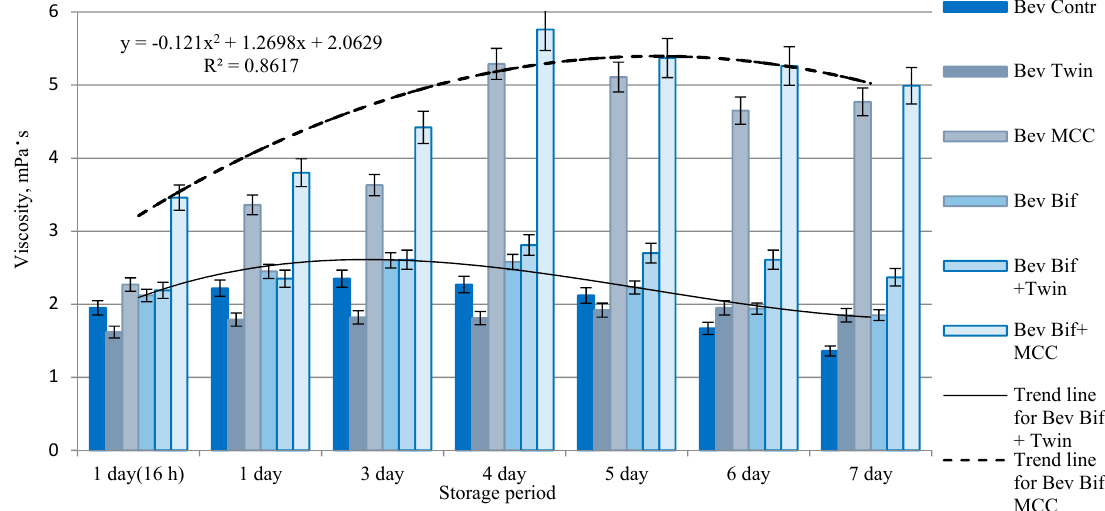
Figure 3. Dynamic viscosity of plant beverages stabilized with ME. The error bars represent the standard deviation of measurements ( n = 5). Designation of samples: Bev Contr—unfermented beverage from hemp seeds, Bev Bif—beverage from hemp seeds, fermented by Bifidobacterium longum ; Bev MCC (Bev Twin)—unfermented beverage from hemp seeds, stabilized by microemulsion with microcellulose (twin-80); Bev Bif+ MCC (Bev Bif +Twin)—beverage from hemp seeds, stabilized by microemulsion with microcellulose (twin-80) fermented by Bifidobacterium longum .